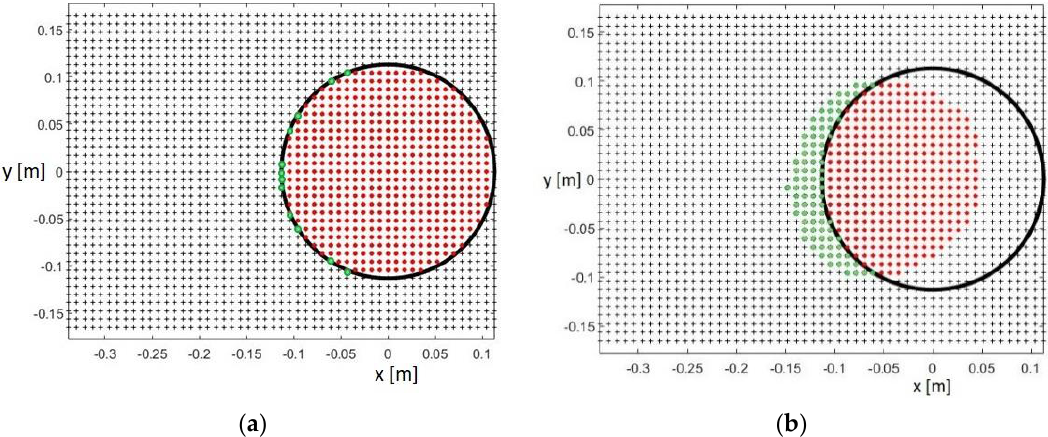
Figure 3. Schematics of the initial positions of the modelled trajectories, colour-coded according to their destination, and projection of the collector’s rim (black circles). Red dots indicate drops that actually fall inside the gauge collector in real conditions and that were expected to do so, while green dots indicate those falling inside the gauge collector instead of outside. ( a ) Low wind and/or heavy particles; ( b ) strong wind and/or light particles.